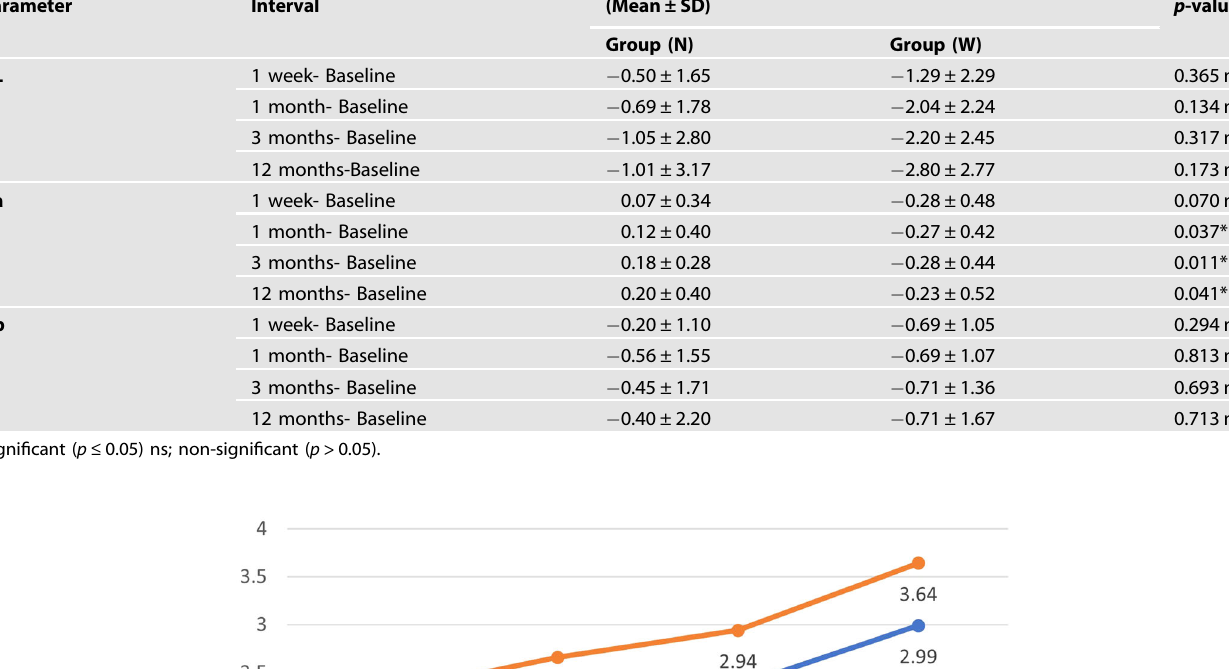
Table 3. Mean and Standard deviation (SD) values for Δ L, Δ a, Δ b in both groups. Parameter